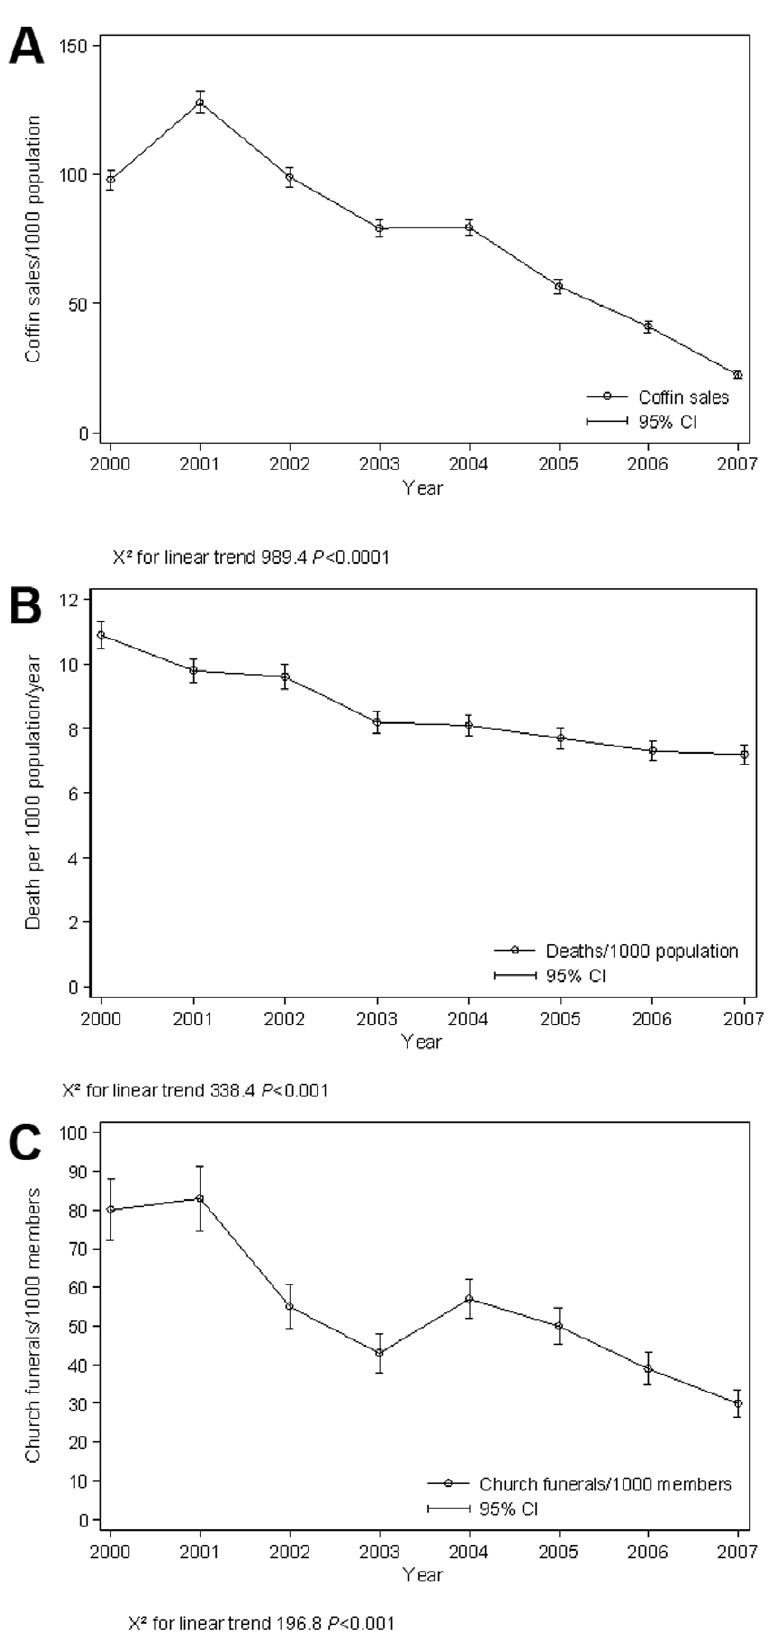
Figure 1. Trends in registered deaths, coffin sales and church funerals. 1a ) Trends in registered deaths at traditional authorities, (2000–2007) Thyolo, District, Malawi. 1b ) Trend in coffin sales (2000–2007), Thyolo, District, Malawi. 1c ). Trend in registered church funerals (2000–2007), Thyolo, Malawi.